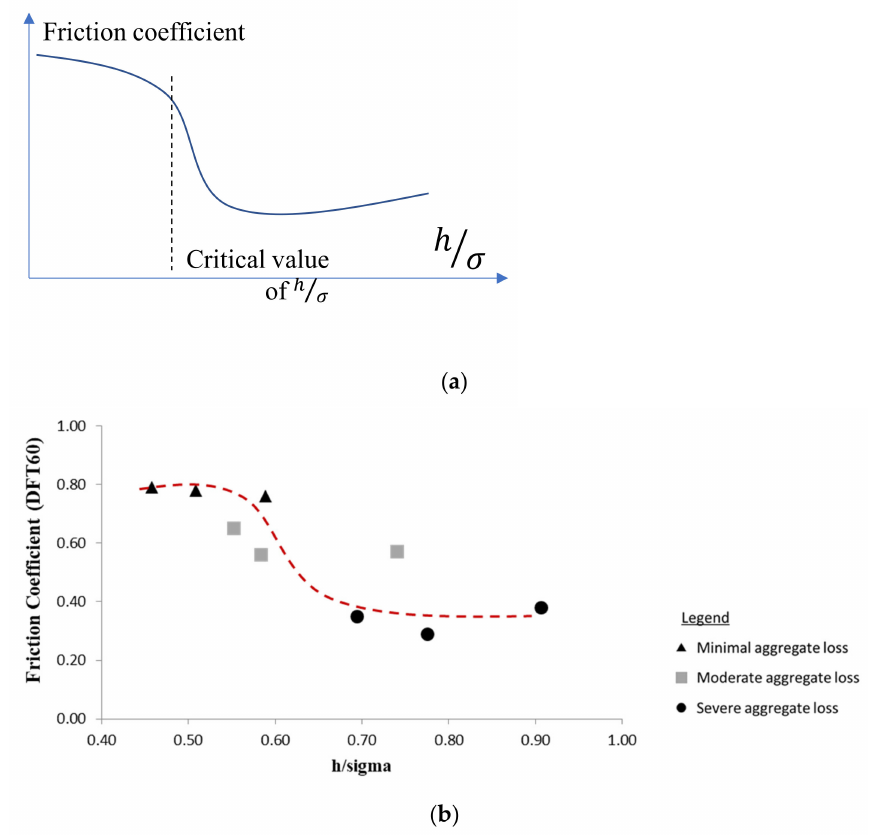
Figure 20. Variation of the coefficient of friction with the ratio h/ σ ( a ) trend from Halling’s work [22] and ( b ) data from the present